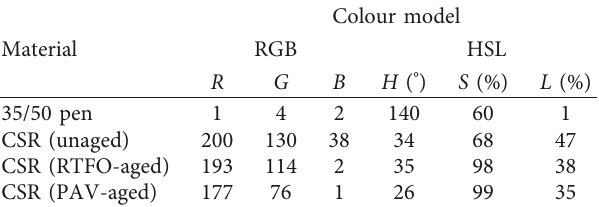
Table 2: Summary of chromatic test